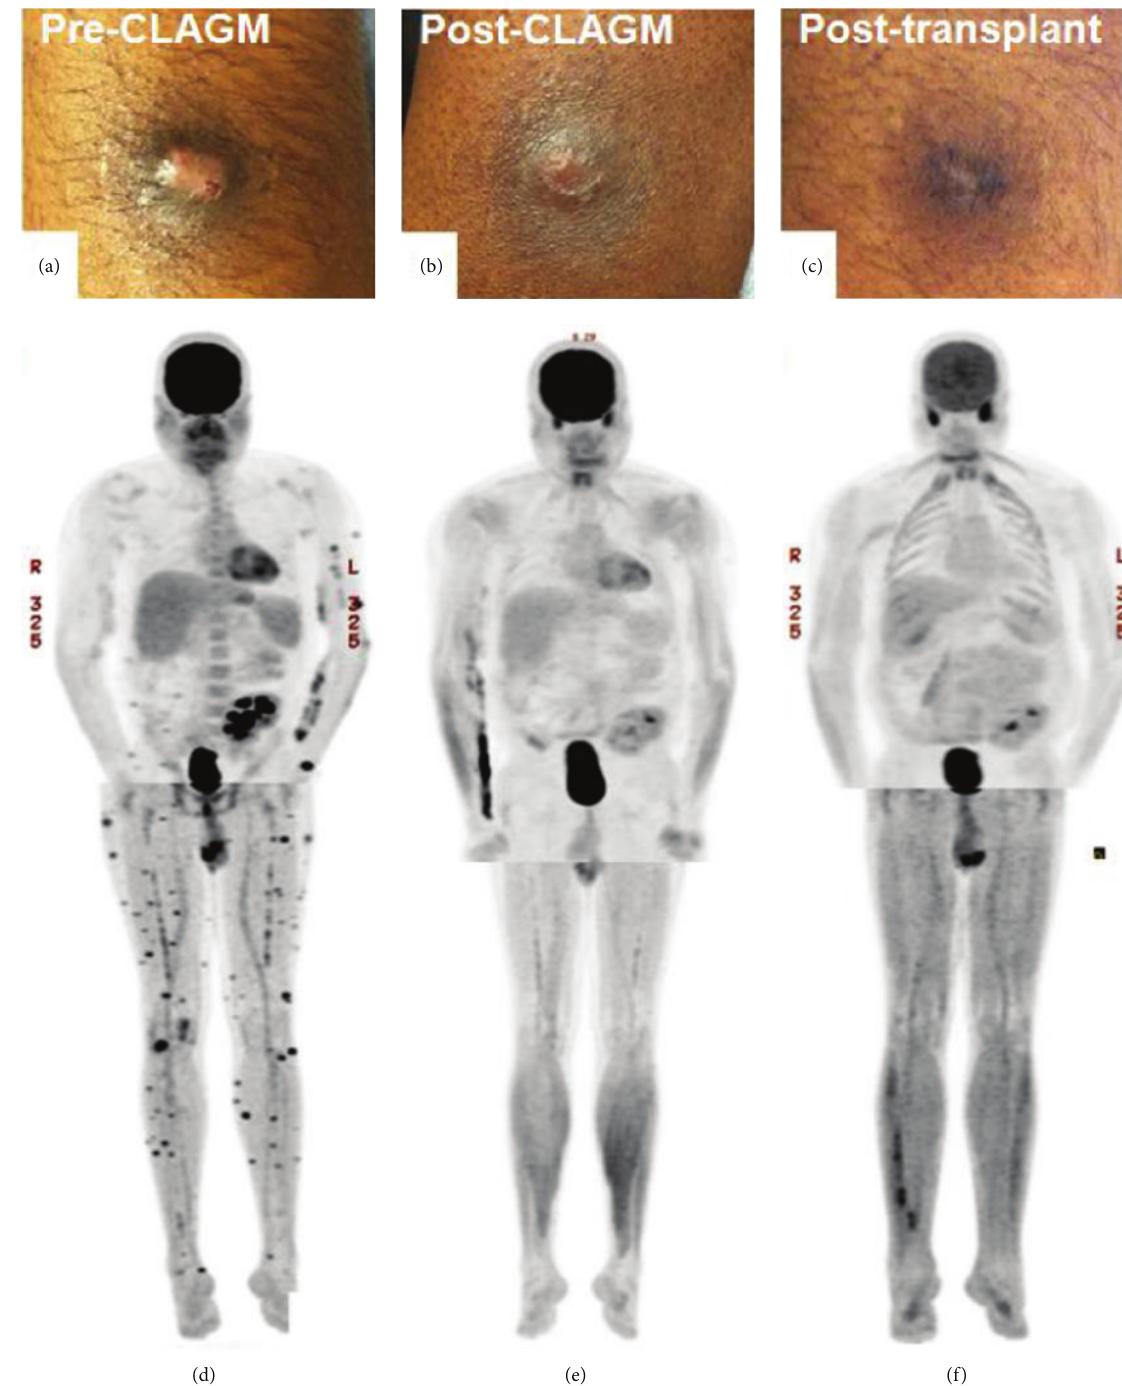
Figure 4: (a, b, and c) Photographs of a pre-CLAG-M, post-CLAG-M, and postallogeneic hematopoietic cell transplant skin lesion. (d, e, and f) Maximum intensity projection from positron emission tomography (PET) of upper body and lower extremity. Images correspond with timing of skin lesions photographed in (a)–(c). (d) After CHOP (cyclophosphamide, doxorubicin, vincristine, and prednisone) and salvage ifosfamide, carboplatin, etoposide (ICE) there was progression of skin disease with innumerable cutaneous foci on PET. (e) Following CLAG- M therapy, near resolution of skin lesions. PET demonstrated improvement in cutaneous foci consistent with response to therapy. (f) Five months following allogeneic hematopoietic cell transplant there is no evidence of metabolically active